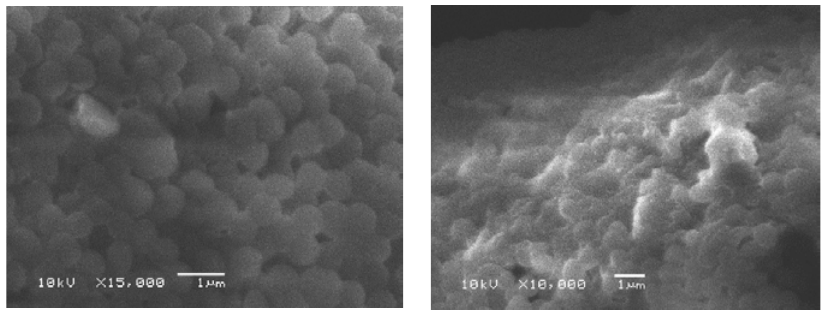
Figure 2. S. aureus in ethanol as control ( left ); S. aureus treated with synthesized compound 7 ( right ).